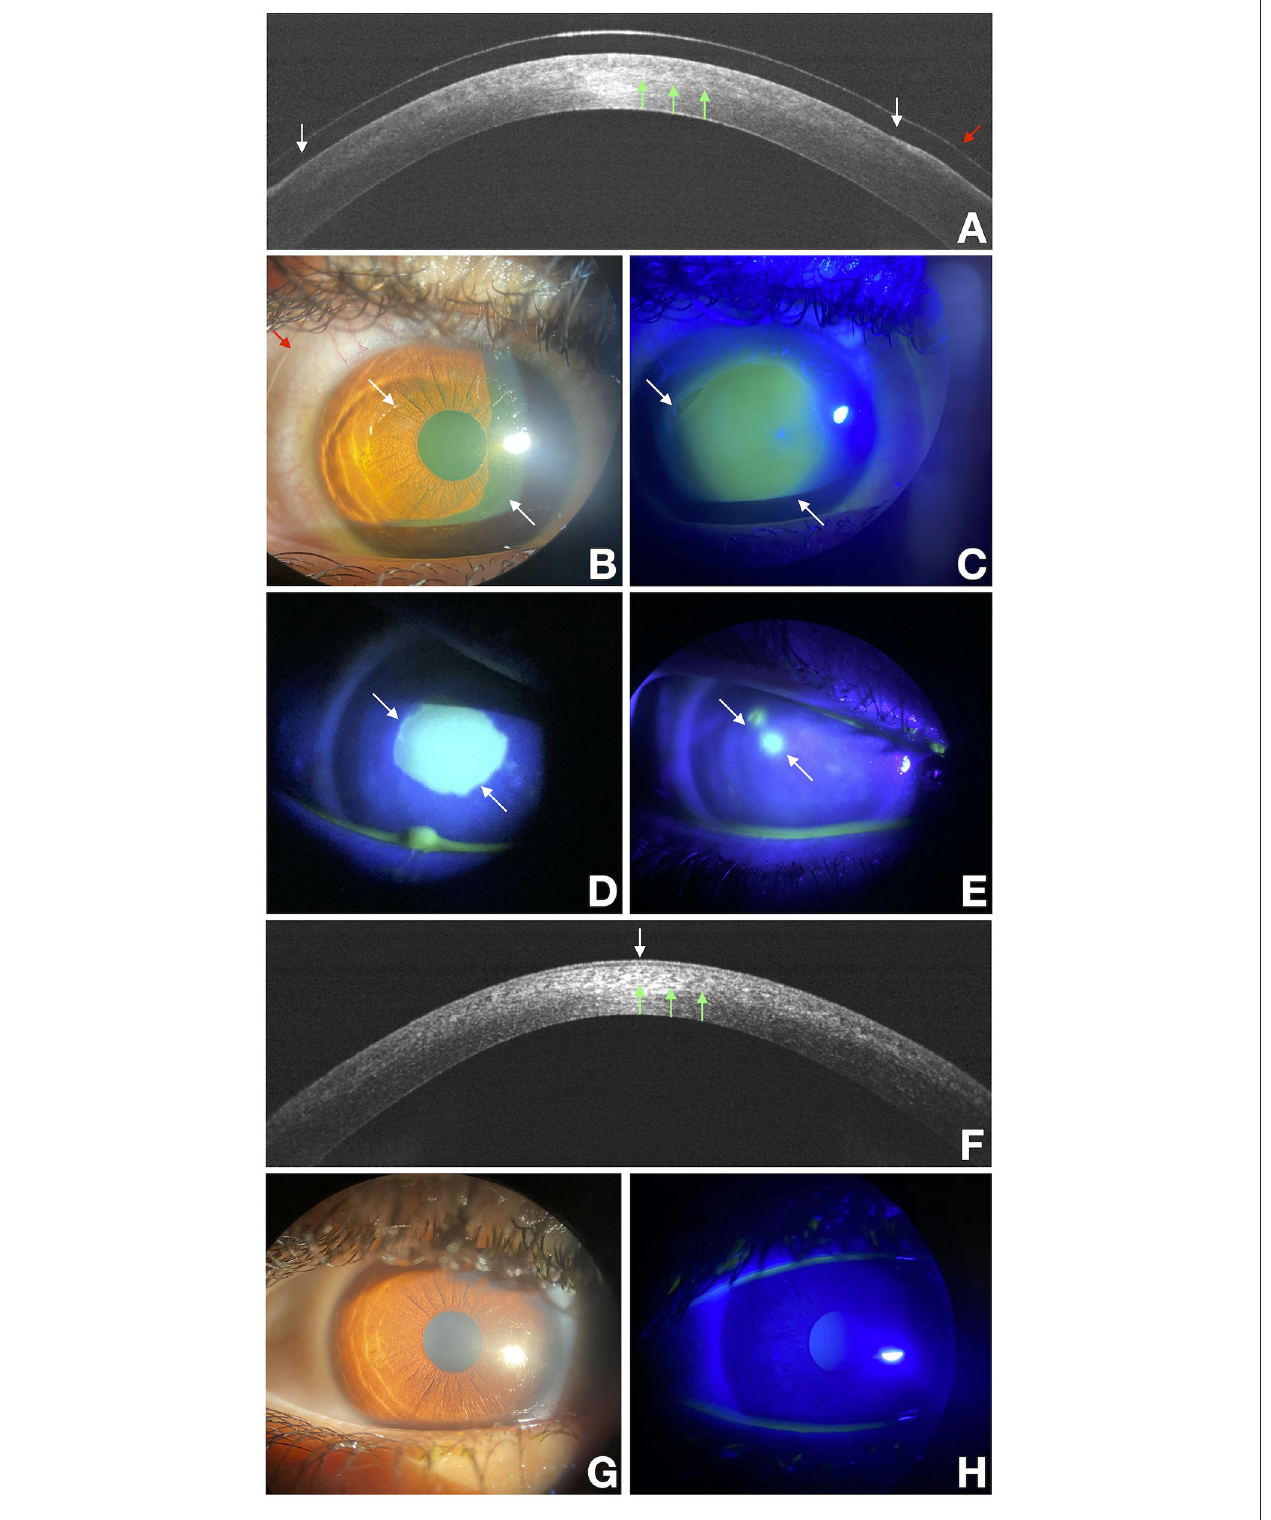
FIGURE 1 | Delayed re-epithelialization after the epithelium-off CXL (epi-off CXL) imaged with a multimodal approach. White arrows point at the edges of the epithelial fronts and green arrows points to the demarcation line, and the red arrow points to the bandage lens. OCT scan over the disepithelized area at baseline (A)